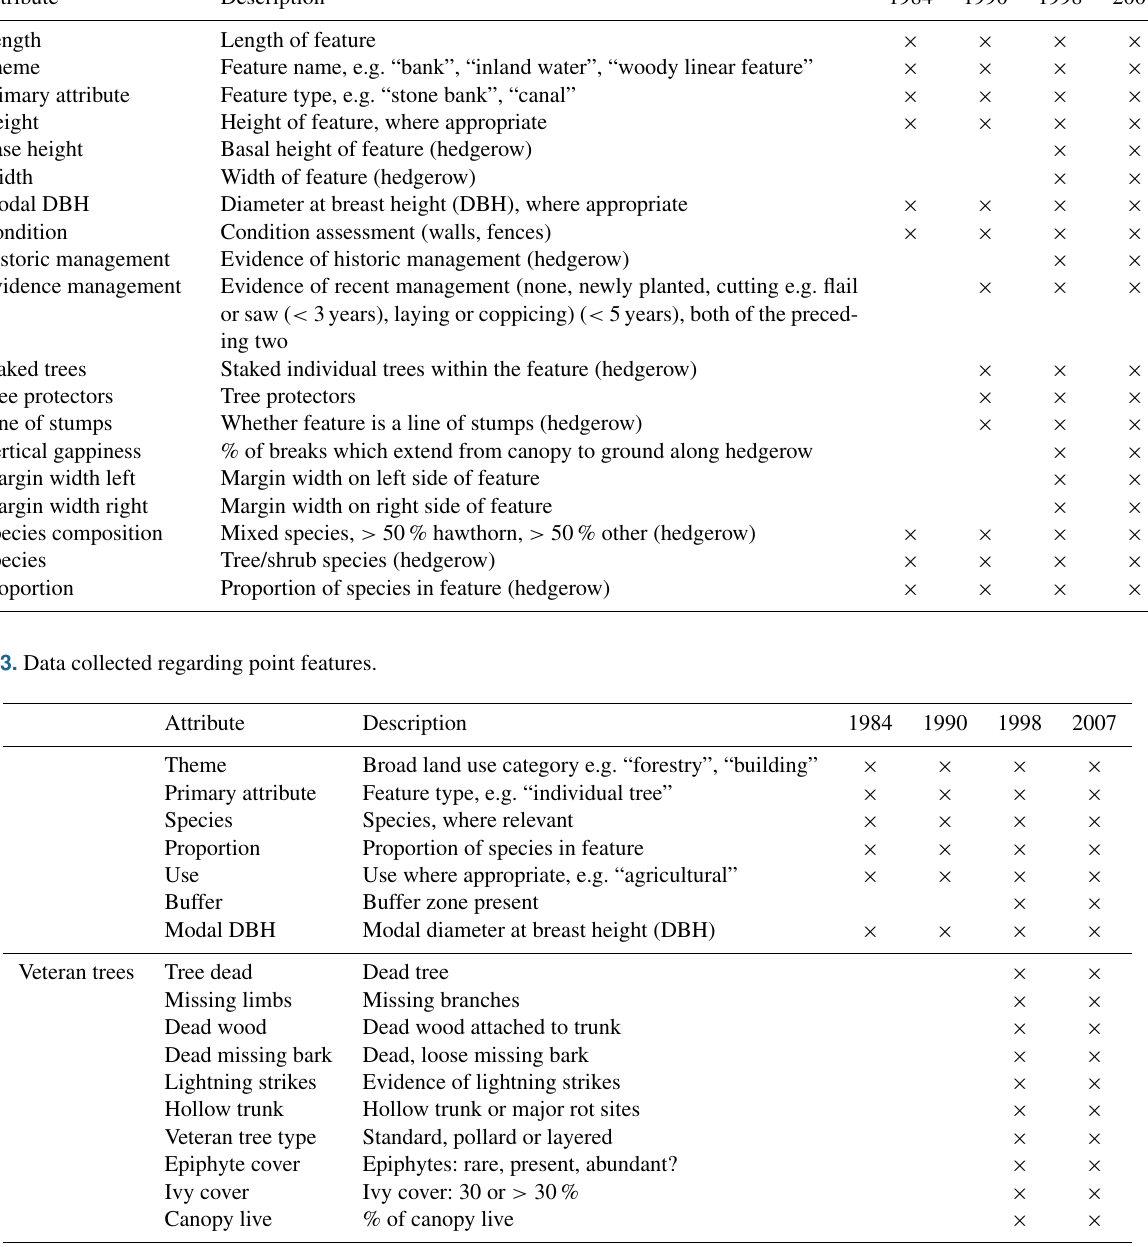
Table 2. Data collected regarding linear features. Attribute